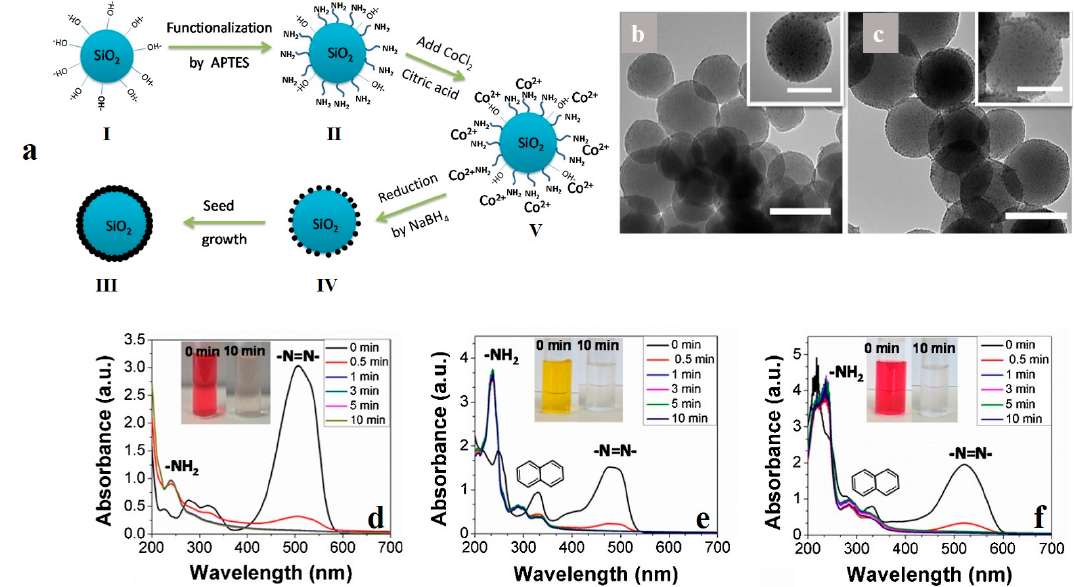
Figure 5. ( a ) The synthesis procedure for SiO 2 -Co core-shell nanoparticles. TEM images imply the SiO 2 -Co core-shell nanoparticles prepared from two different Co 2+ precursor amounts of ( b ) 1 mM and ( c ) 2 mM Co 2+ (Scale bar in the main image and inset represents 100 nm and 50 nm, respectively). UV/Vis spectra indicate the model dye degradation by the core-shell nanoparticles over time (note that the solutions’ pH was acidic (pH 2.5) and the initial dye concentration was 0.076 mM) ( d ) Methyl Orange. ( e ) Orange G. ( f ) Amaranth. Reproduced with permission [103]. Copyright 2016, Elsevier.